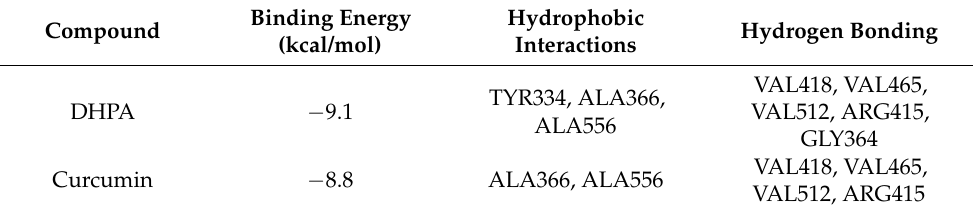
Figure 7. Effects of DHPA on the Keap1/Nrf2/HO-1 signaling pathway in A β (1–42) /Cu 2+ /AA-induced SH-SY5Y cells. ( A ) Representative Western blot were shown for Keap1, cyto-Nrf2, Nucl-Nrf2, Histone H3, HO-1 and NQO1 proteins. Keap1 ( B ), cyto-Nrf2 ( C ), Nucl-Nrf2 ( D ), HO-1 ( E ), and NQO1 ( F ) protein expressions were evaluated by the WB analysis. * p < 0.05 and ** p < 0.01 compared to control values. Table 1. Docking information of the interaction of Keap1 and small